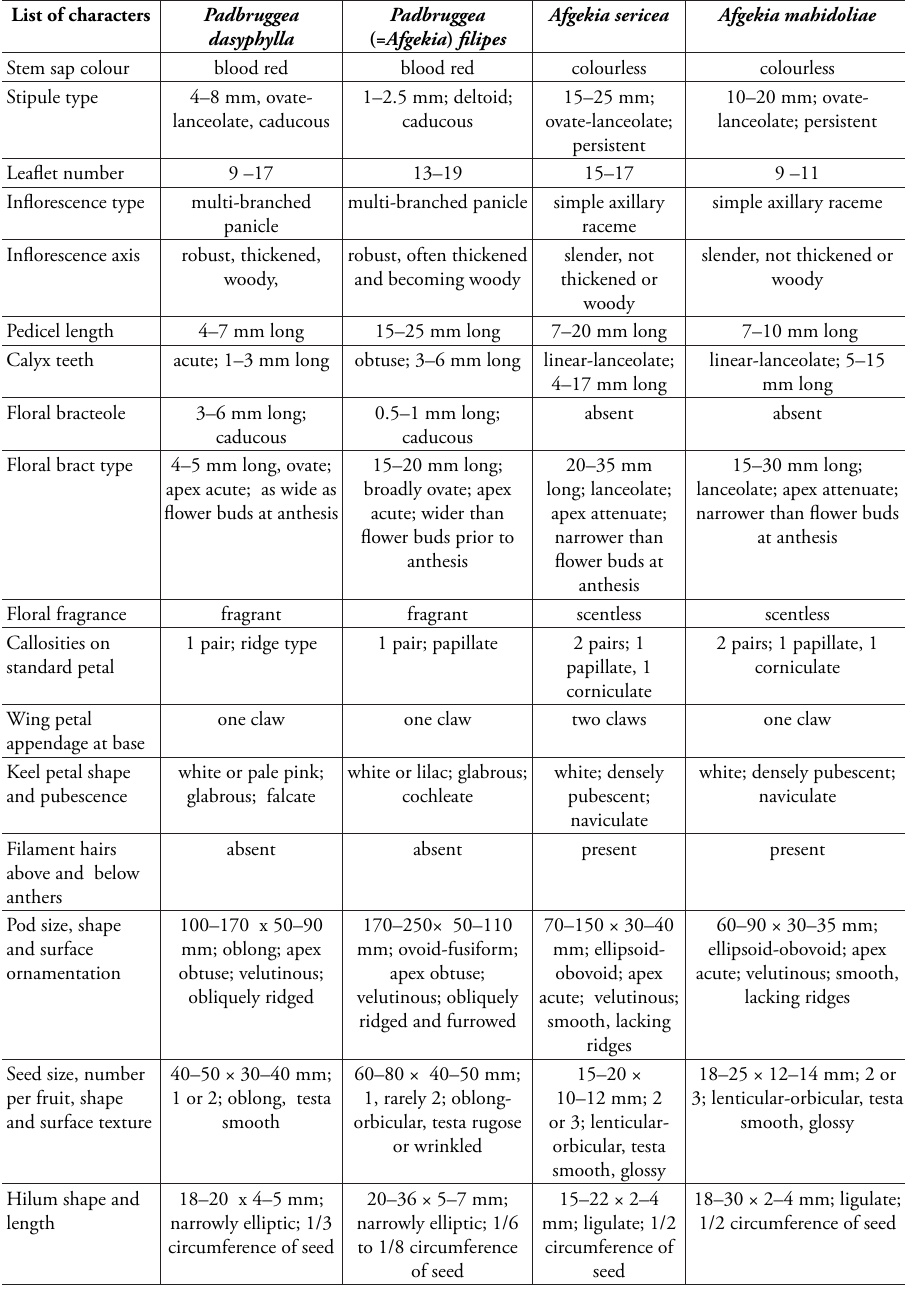
Table 5. Morphological characters distinguishing Afgekia and Padbruggea . Comparison is made of critical characters of these genera in support of the transfer of A. filipes to Padbruggea